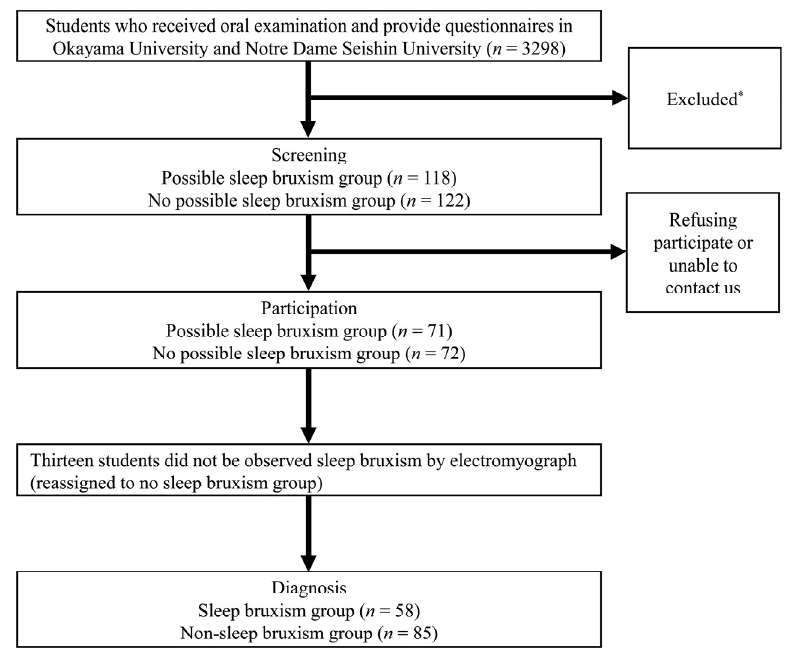
Figure 2. Process of assignment to the sleep bruxism and non ‐ sleep bruxism groups. * Students who answered “yes” to Q1 and “frequently/sometimes/rarely” to Q2 or Q3 or had abnormal tooth wear were excluded.